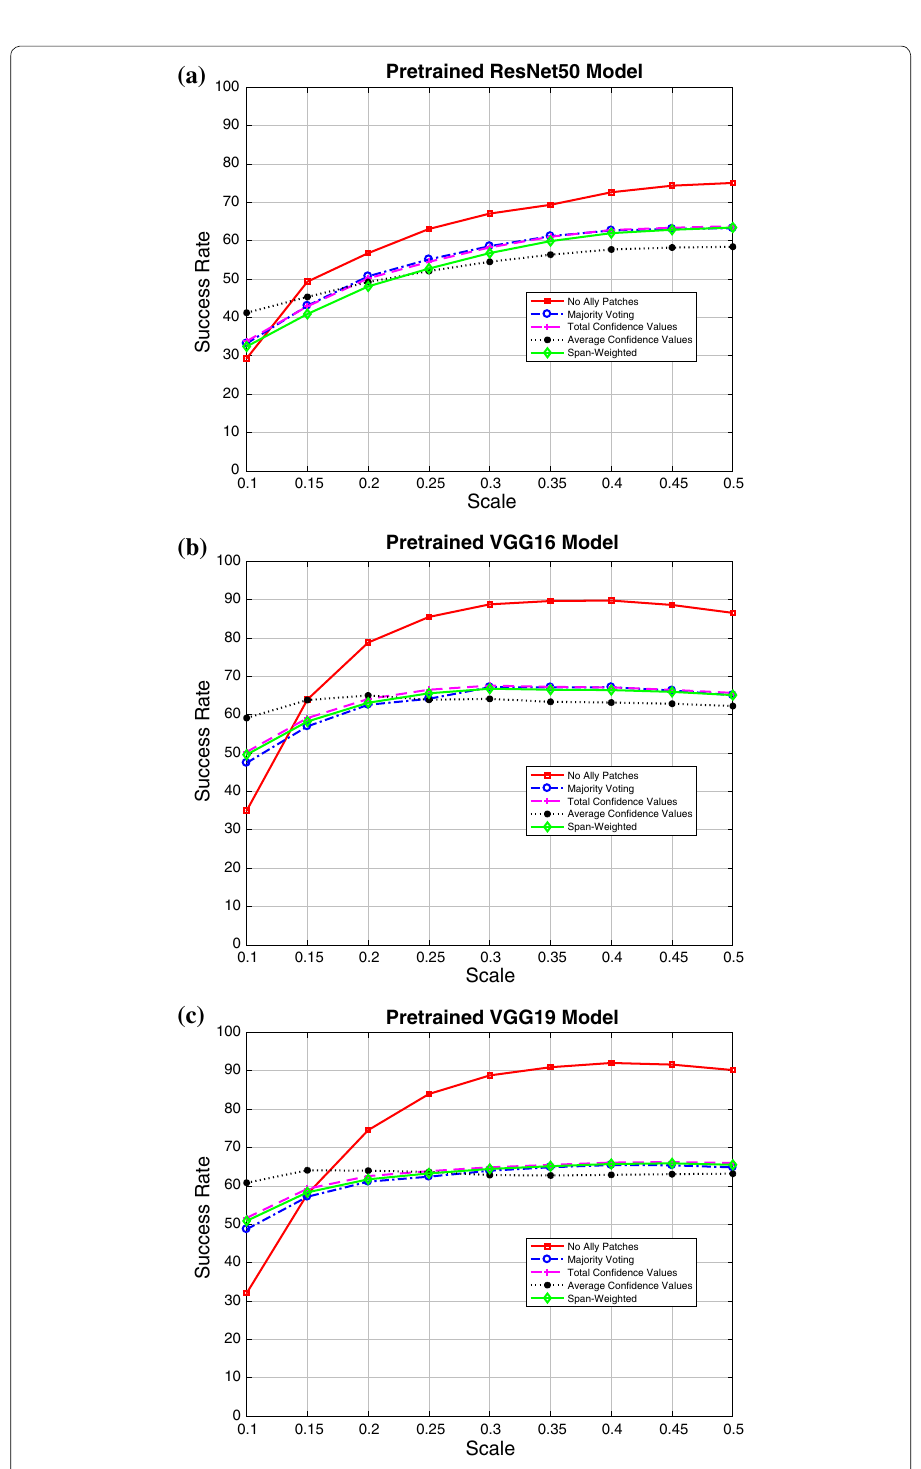
Fig. 4 The success rates before and after using the proposed ally patches with three different pre‑trained CNN models: a ResNet50 [10], b VGG16 [22], and c VGG19